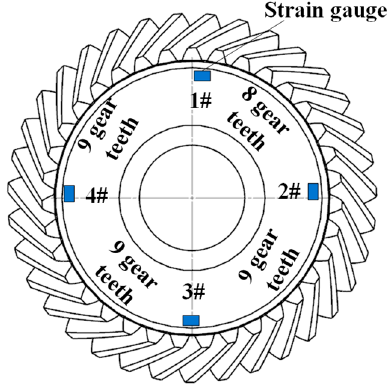
Figure 4. Diagram of strain gauge patch position.